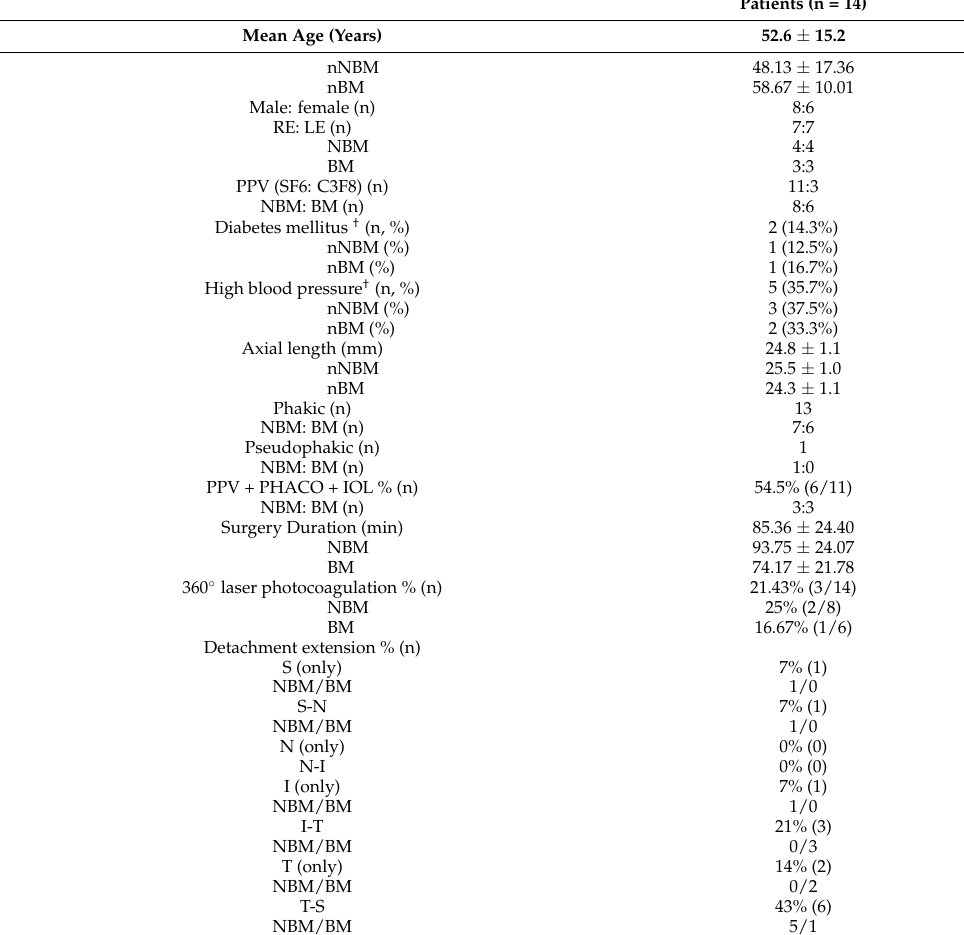
Table 1. Demographics, ocular characteristics and surgical techniques